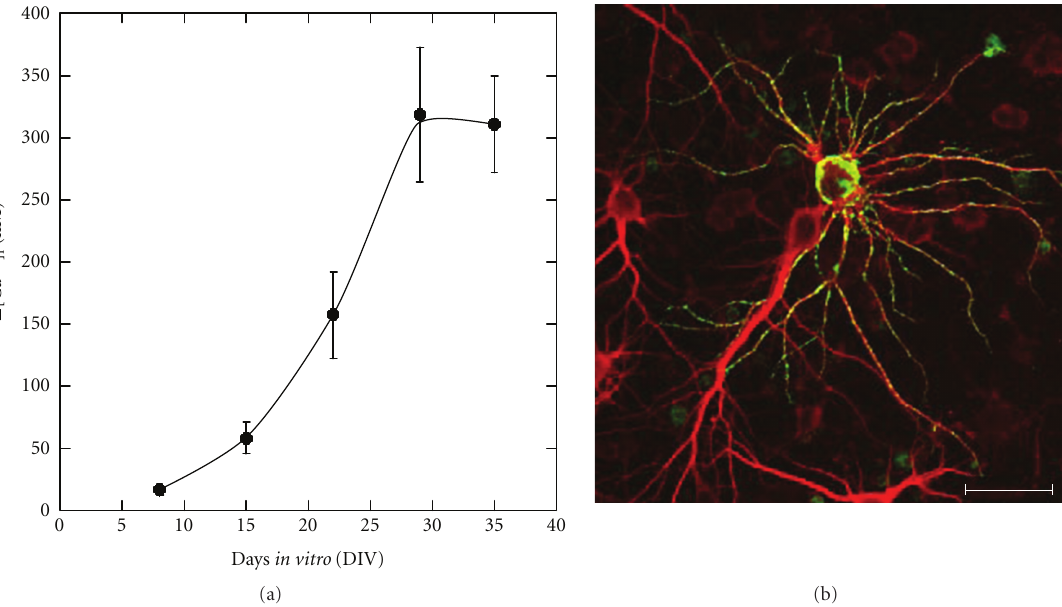
Figure 5: (a) Maturation-dependent increase in A β P-induced [Ca 2+ ] i changes in primary cultured neurons. (b) Heterogeneous a ffi nity of A β P to mature cultured hippocampal neurons. Long-term cultured rat hippocampal neurons were exposed to 1 μ M of A β P(1–40) at 29 DIV and fixed after 4 days. Neurons were double immunostained by anti-MAP2 antibody (Texas Red, red) and anti-A β P antibody (FITC, green), and observed by Laser confocal microscopy. Scale bar represents 50 μ m. (modified from